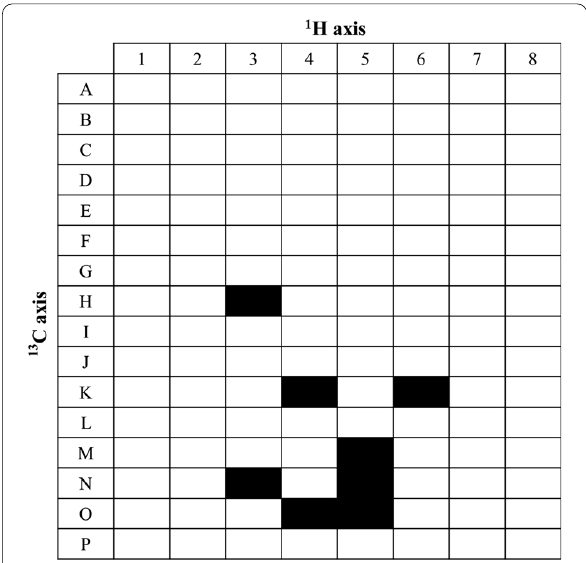
Fig. 5 Cross‑peaks region of Cupressaceae exudate in HSQC